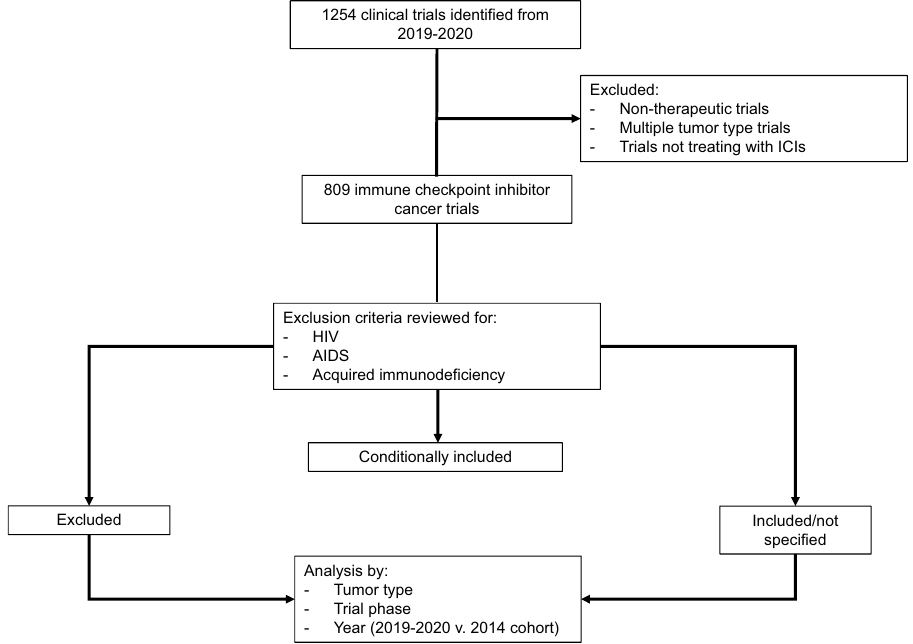
Figure 1. Cancer immune checkpoint inhibitor 2019–2020 trial cohort collection, categorization, and analysis methods. Cancer immune checkpoint inhibitor trials with planned start dates in 2019 and 2020 were collected using keyword searches, resulting in 1254 trials. Non-therapeutic trials, trials allowing multiple tumor types, and trials not treating with immune checkpoint inhibitors were excluded, leaving 809 remaining trials.